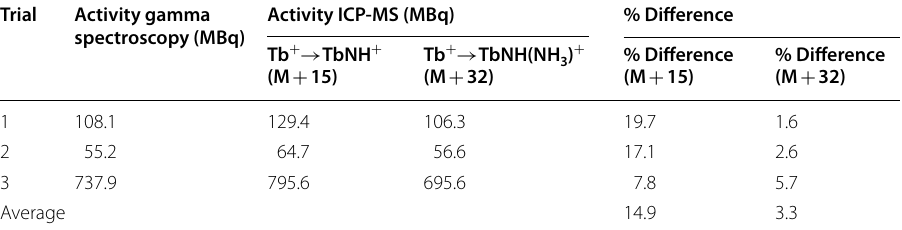
Table 3 Comparison of ICP-MS calculated 161 Tb activity to HPGe Gamma spectroscopy measured 161 Tb